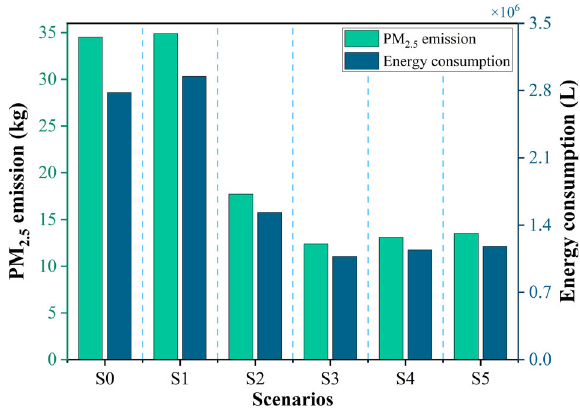
Fig. 4 The impact of different development scenarios on energy and environment. Green columns: PM 2.5 emission under different regional development scenarios across the study area. Blue columns: the impact of different development scenarios on energy consumption. It can be found that SAV fares have an important non- linear relationship with the energy and environmental impacts of SAVs.